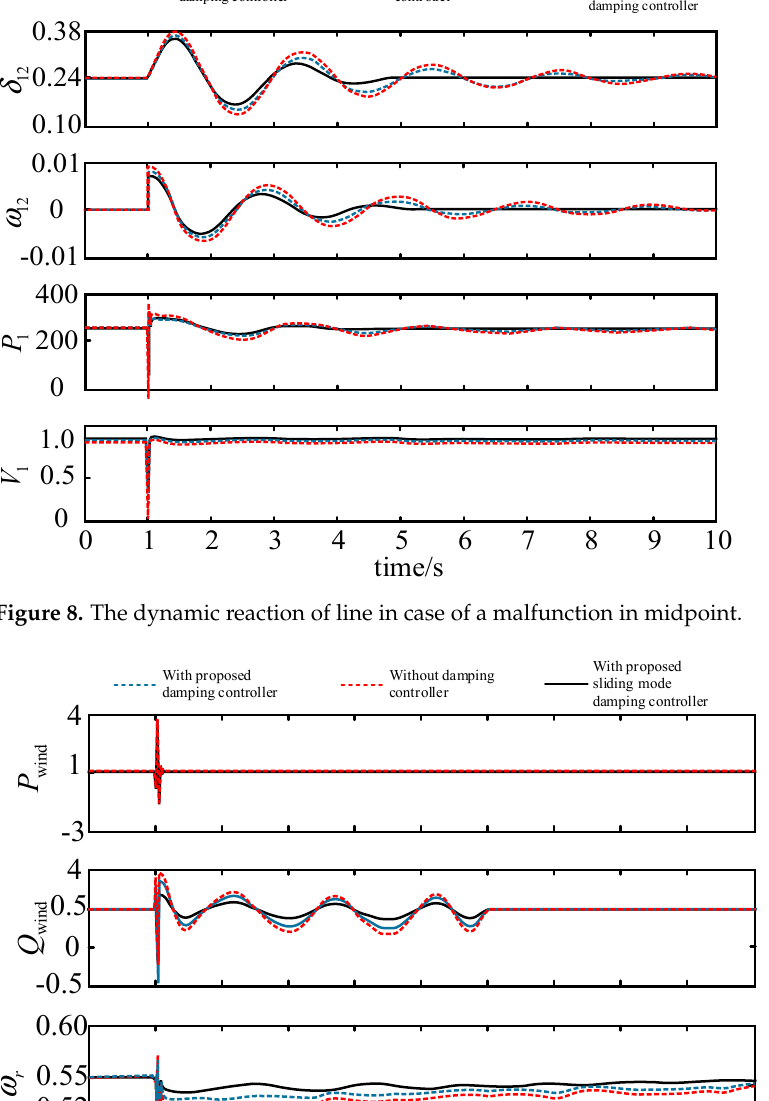
Figure 7. The dynamic reaction of DFIG in case of a malfunction in bus 1.